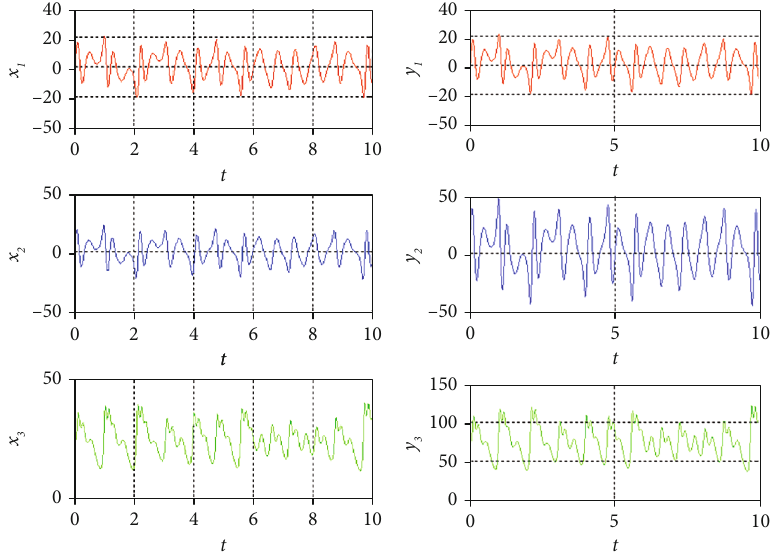
Figure 2: Time histories of di ff erent state variables in the unidirectionally coupled Chen system with the linear manifold y = Px + Q